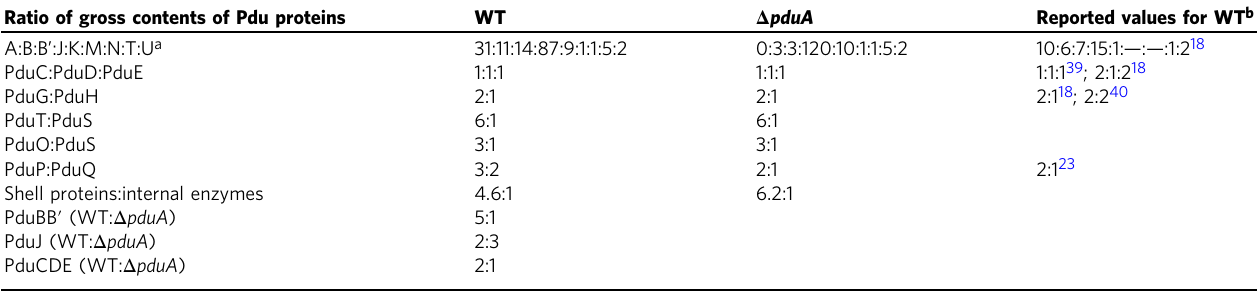
Table 2 Different ratios calculated from the data of gross number of proteins per Pdu MCP. Ratio of gross contents of Pdu